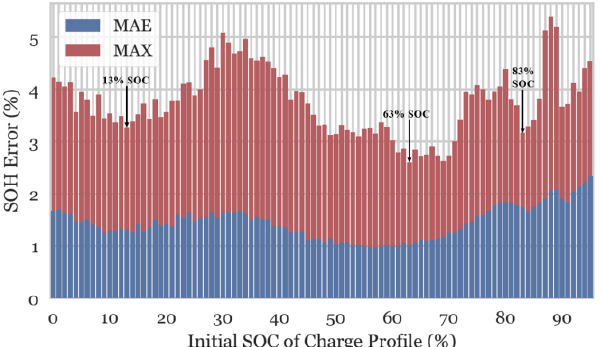
Figure 9. MAE and MAX values of SOH estimation performed over charge profiles beginning at various SOC values. The partial charge profiles are obtained from the NASA prognostics repository and are about 43 min long. The stated ranges of the partial profiles are ranges of the new battery cell before it has aged.